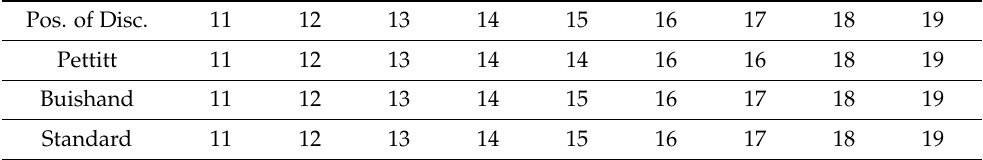
Table 8. The performance of homogeneity tests in capturing the discontinuity. Pos. of